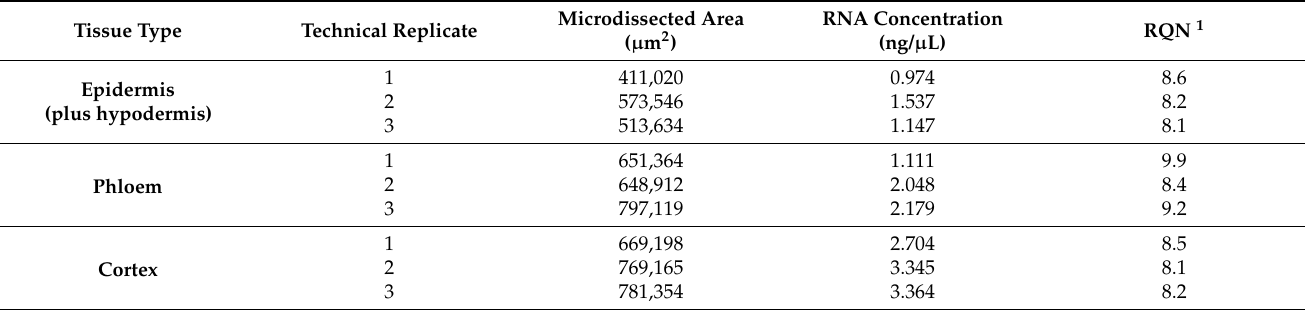
Table 1. Microdissected area and the corresponding yield and quality of the RNA isolated for each tissue type and per technical